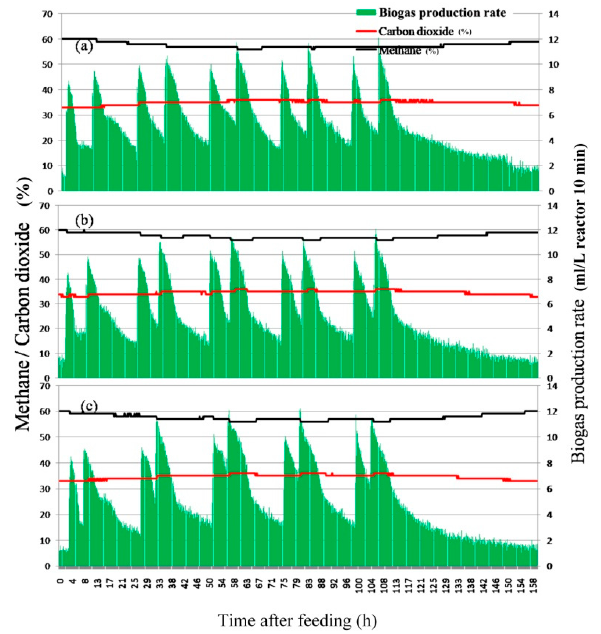
Figure 2. Experimental results of biogas production with feeding twice per day, feeding OLR = 1.90g COD L − 1 digester day − 1 : ( a ) 9 h feeding time interval; ( b ) 7 h feeding time interval; ( c ) 5 h feeding time interval.